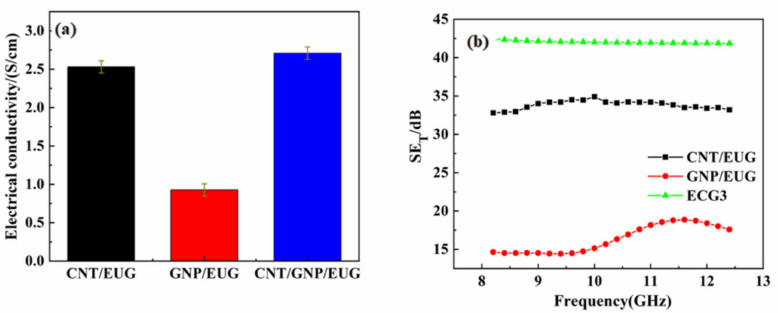
Figure 6. Comparison of ( a ) electrical conductivity and ( b ) EMI SE T of CNT/EUG composite (13.47 wt% CNT), GNP/EUG composite (13.47 wt% GNP) and CNT/GNP/EUG composite (9.62 wt% CNT and 3.85 wt% GNP, ECG3).